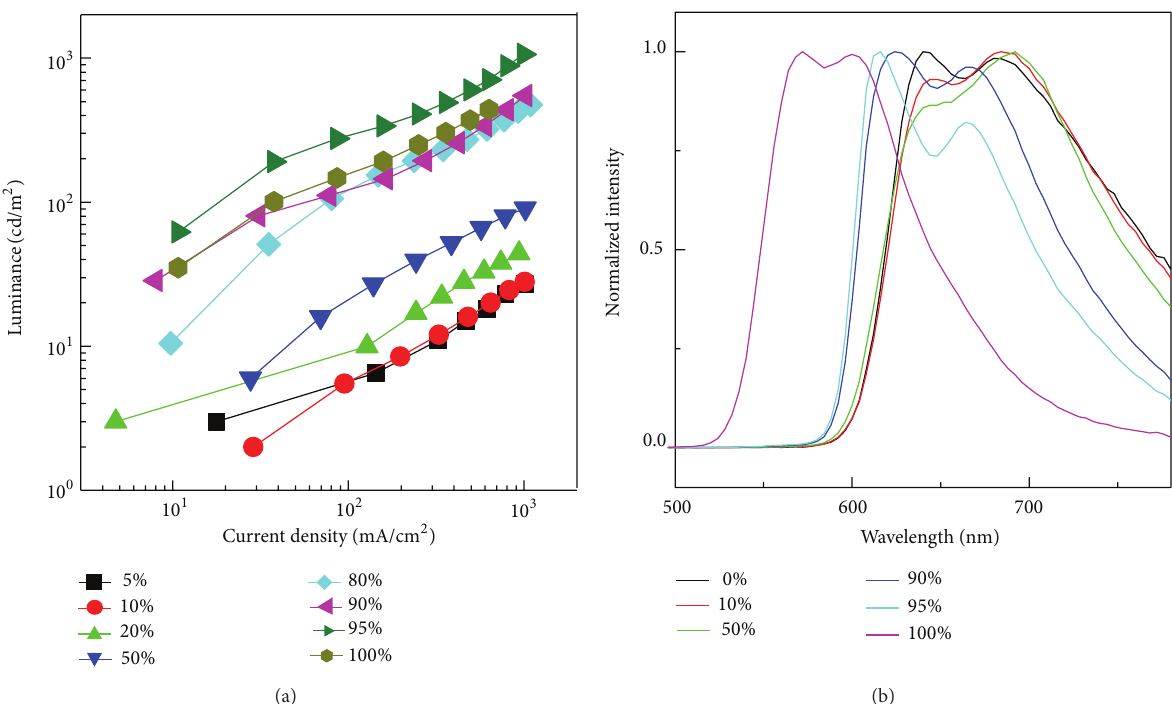
Figure 4: (a) Luminance as a function of current density and (b) normalized emission spectra for various rubrene ratios of the EL-EDL. Legends in the figures show the rubrene percent